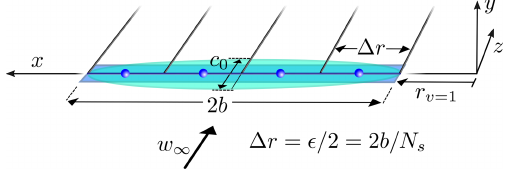
Figure 5. Definition of the wing test cases with either a rectangular or elliptic planform. Vortices are trailed in-between sections and the actuator line forces are computed and exerted at the sections’ centres. Table 1. Input parameters common to both rectangular and elliptic wing simulations.